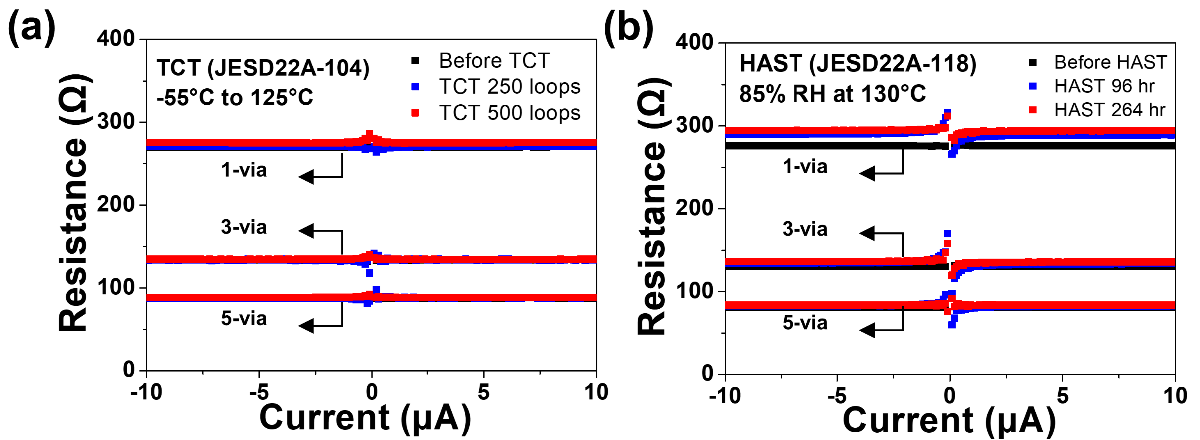
Figure 13. Rsistance change of daisy chain ( n = 216) measurement before and after ( a ) thermal cycling test (TCT) and ( b ) highly accelerated stress test (HAST), respectively.